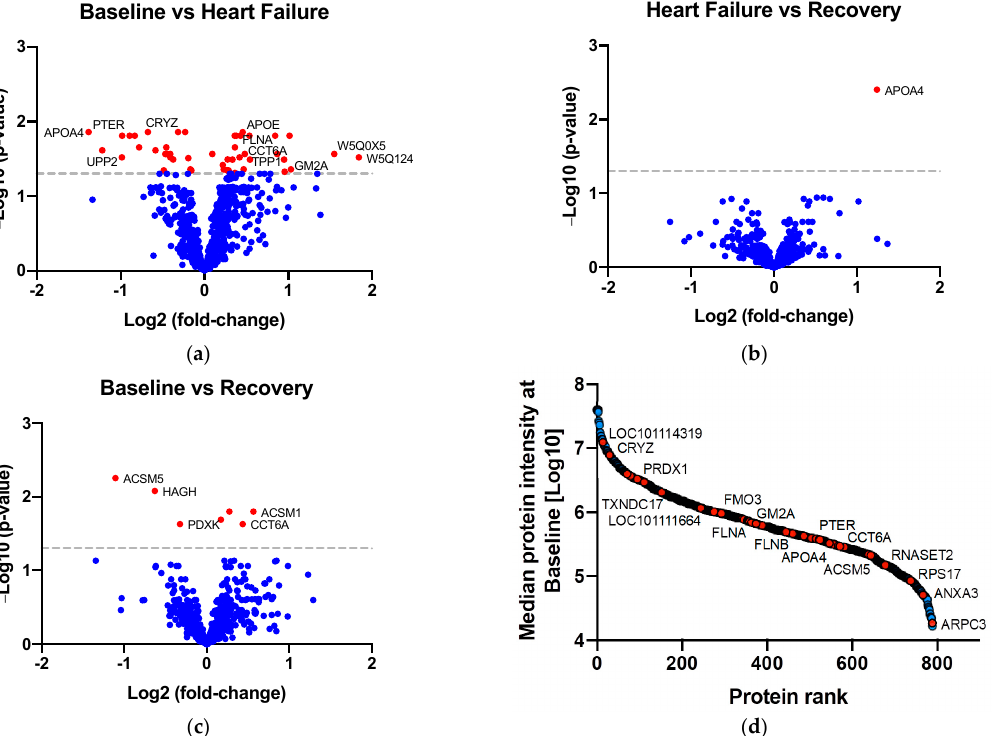
Figure 2. Volcano plots displaying − LOG 10 of the Benjamini–Hochberg (BH) p -value against LOG 2 of the protein fold-change for ( a ) Baseline vs. ADHF, ( b ) Heart Failure vs. Recovery, and ( c ) Baseline vs. Recovery. Red data points in the volcano plots indicate a BH p -value < 0.05; blue data points indicate a BH p -value ≥ 0.05. The horizontal dashed line represents p = 0.05. ( d ) In total, 790 proteins were quantified across four orders of magnitude of mass spectrometry signal. Proteins of differ- ential abundance between timepoints with a fold-change ≥ 1.2 and Benjamini–Hochberg adjusted p -value < 0.05 are coloured red; proteins with a fold-change < 1.2 and/or an adjusted p -value ≥ 0.05 are coloured